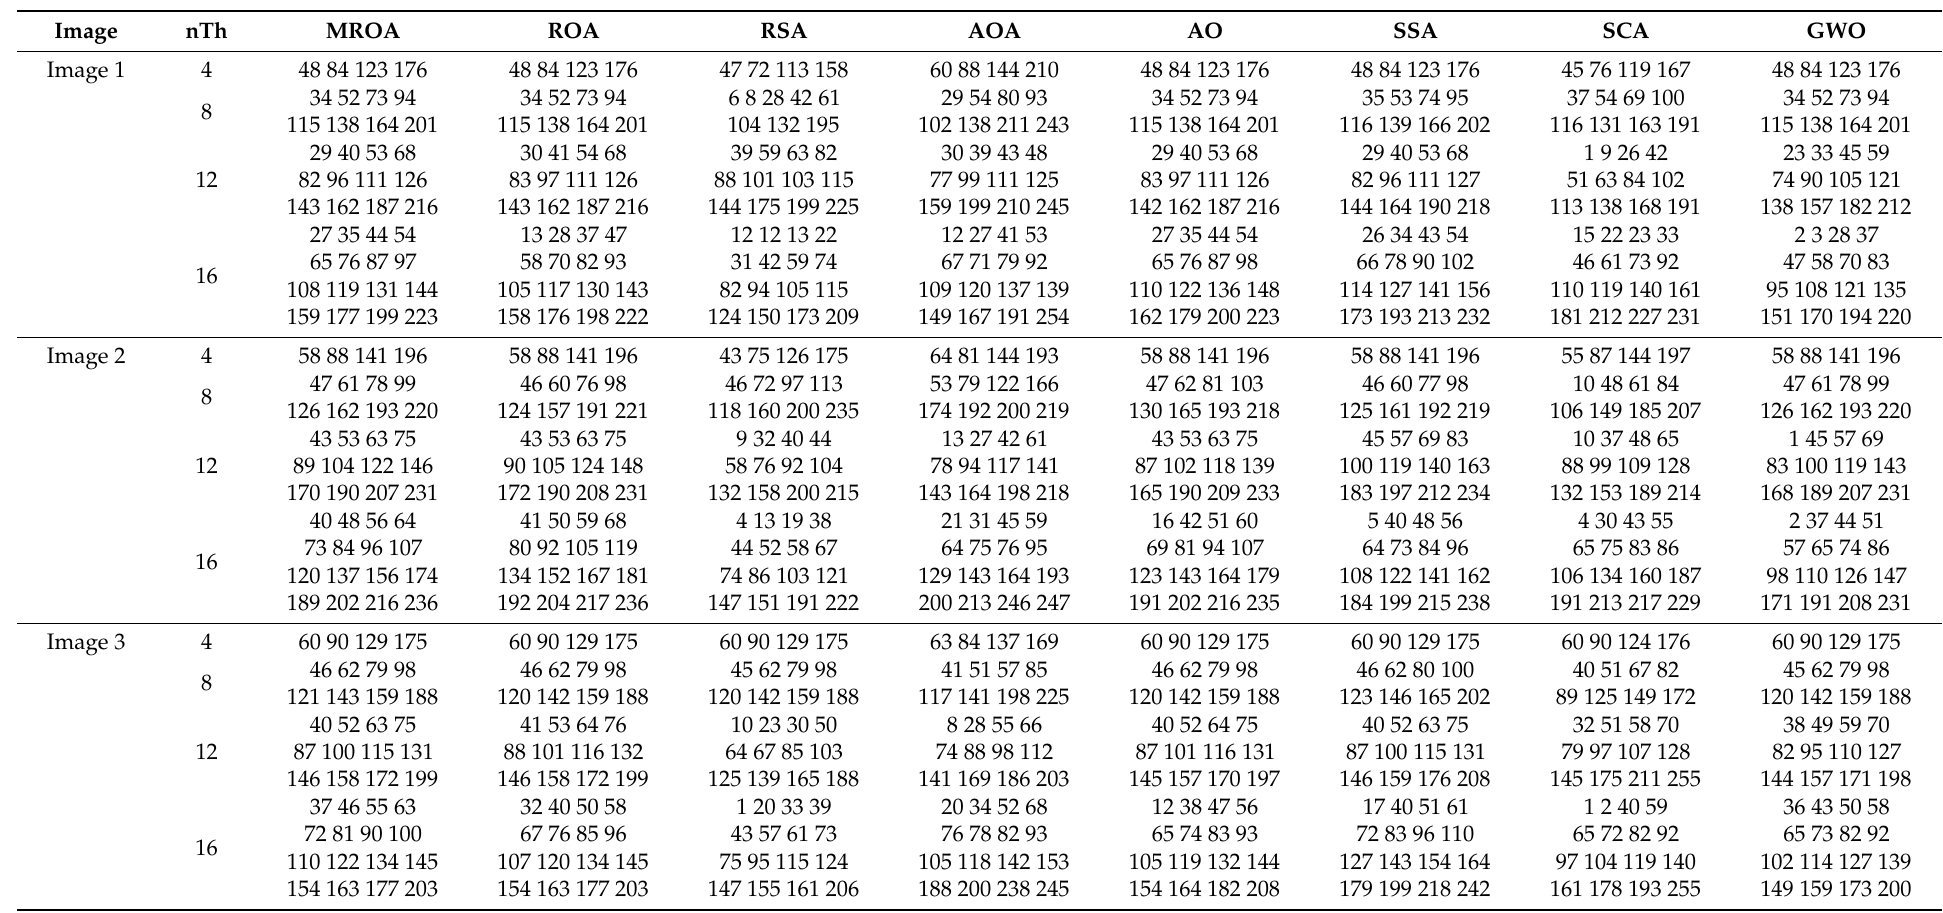
Table A1. The best threshold values obtained by algorithms over all